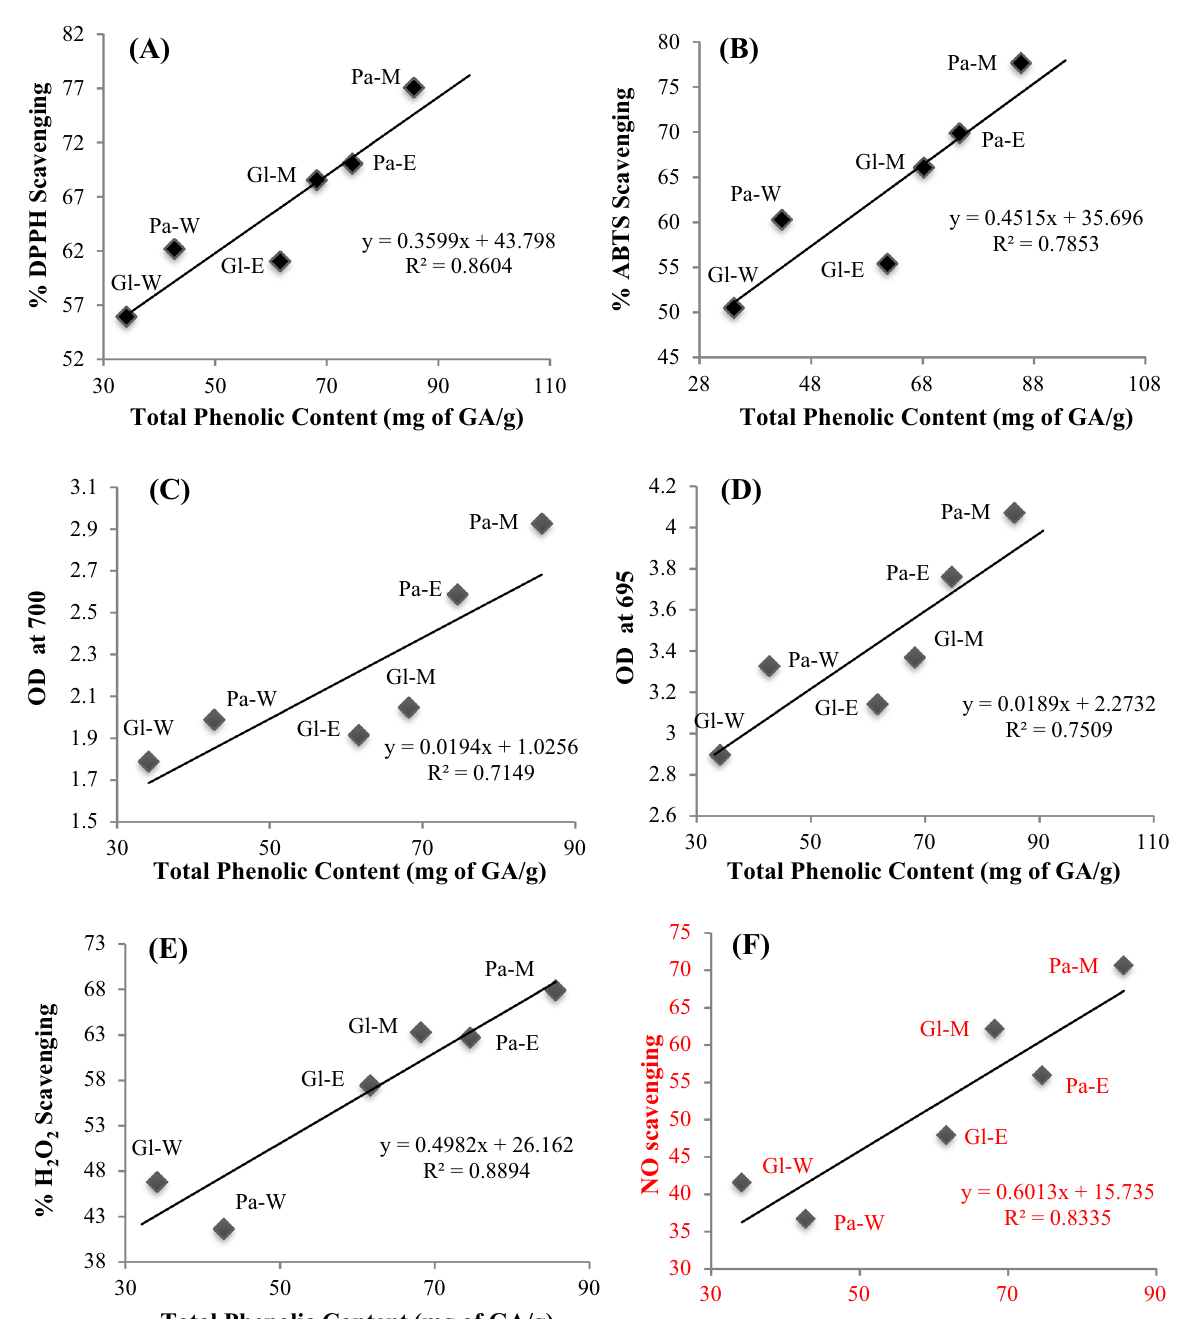
Figure 3. Scatter plot diagrams showing the correlation of total phenolic content (mg of GA/g) vis-à- vis ( A ) DPPH (n = 6; R 2 = 0.8604), ( B ) ABTS (n = 6, R 2 = 0.7853), ( C ) Reducing ability (n = 6, R 2 = 0.7149), ( D ) Phosphomolybdenum (n = 6, R 2 = 0.7509), ( E ) H 2 O 2 scavenging activity (n = 6, R 2 = 0.8894), (F) NO scavenging (n = 6, R 2 = 0.8335) and ( G ) total flavonoid content (n = 6; R 2 = 0.9263). Pa— Padina tetrastromatica